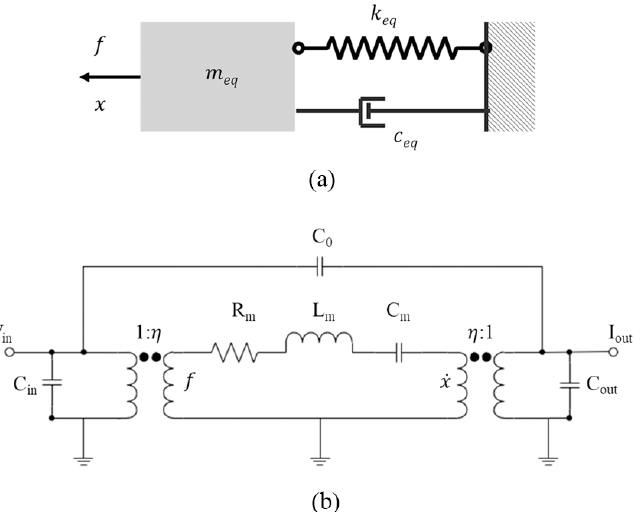
Figure 1. ( a ) Mass damping spring system; ( b ) Equivalent electrical model including feedthrough capacitor and parasitic capacitance.